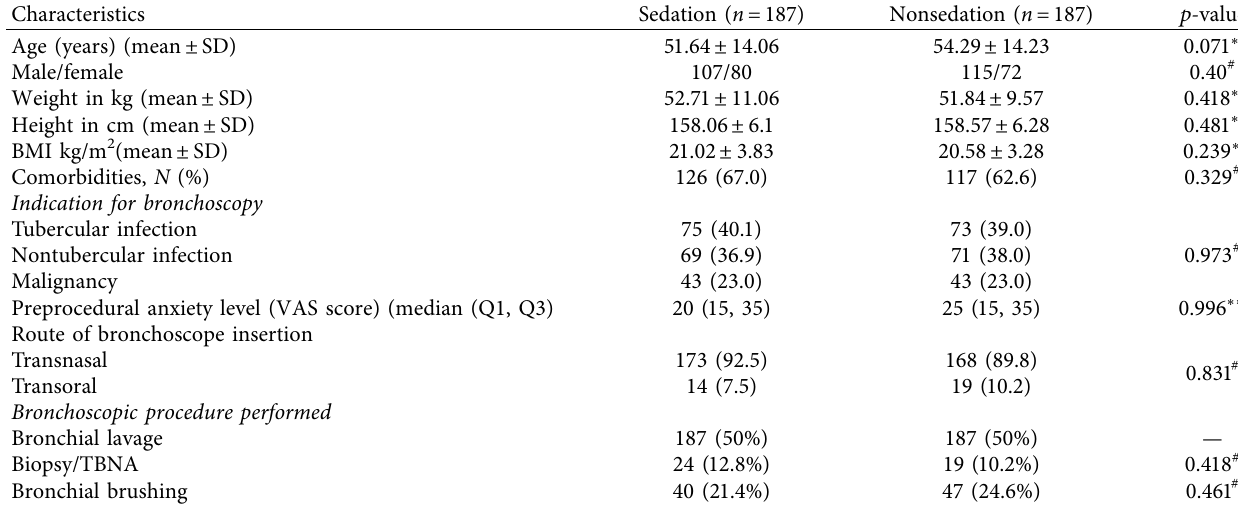
Table 1: Demographic characteristics of patients in sedation and nonsedation groups ( n � 374).